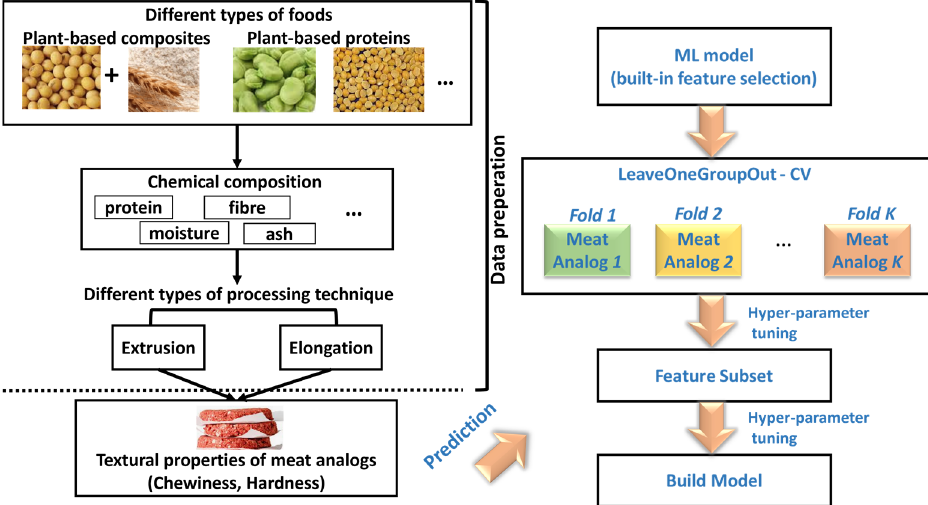
Figure 1. Overall framework for textural property prediction.